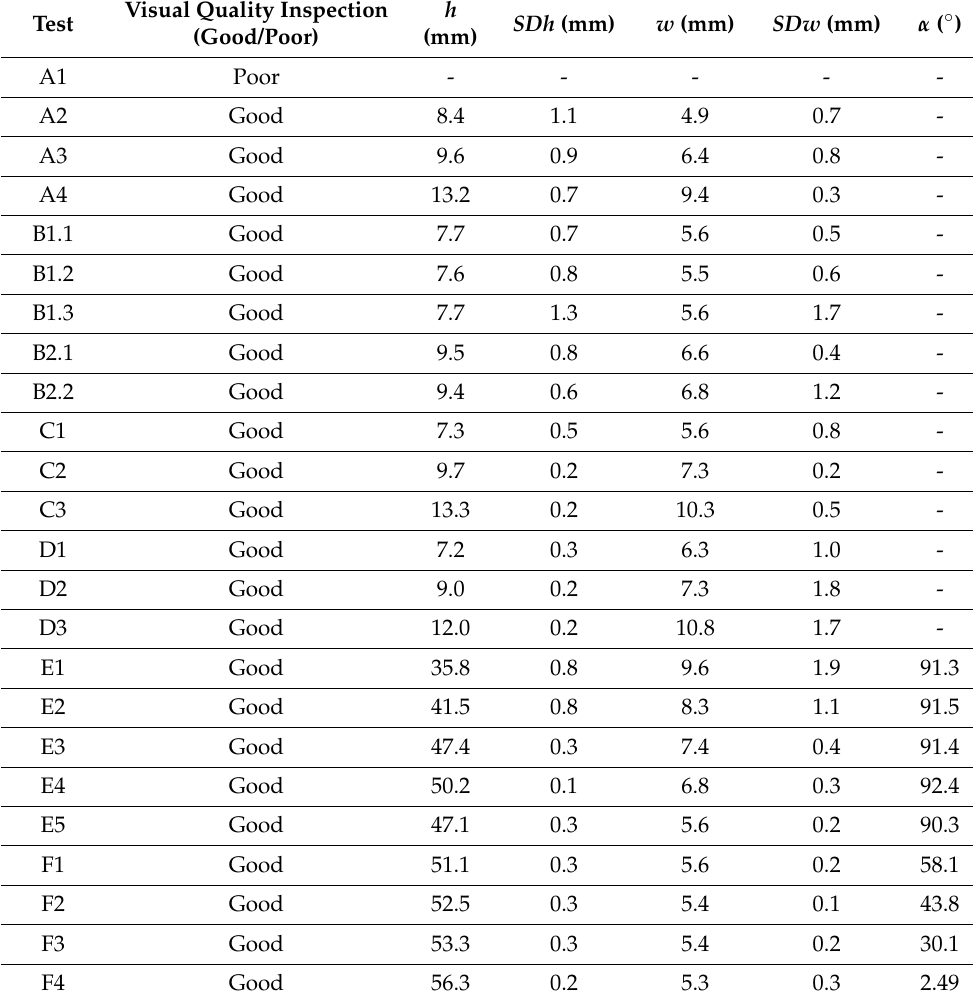
Table 4. Results of the A to F, WAAM